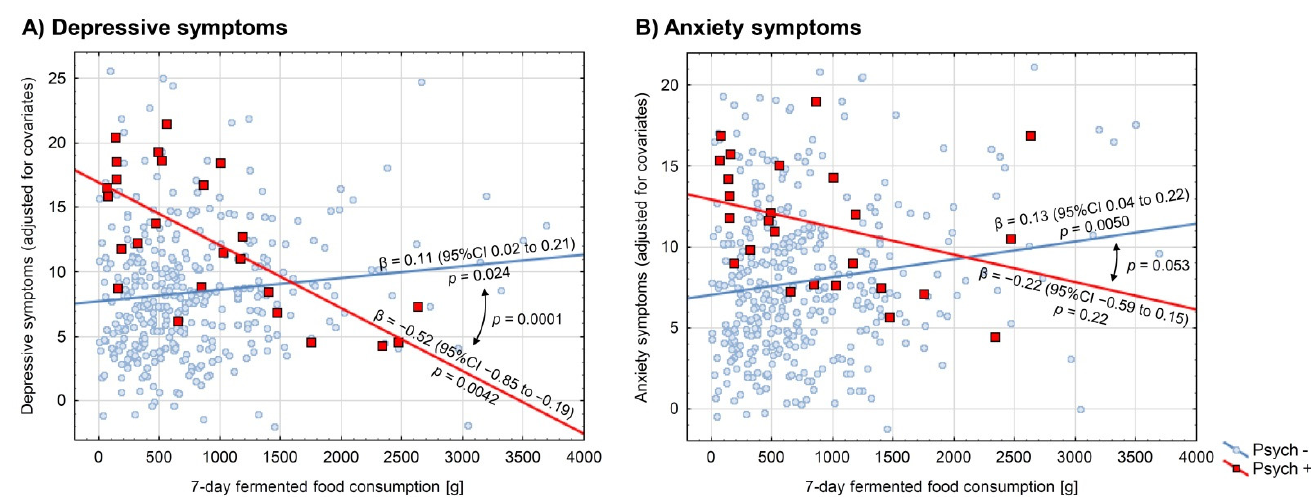
Figure 1. Association between consumption of fermented food and ( A ) depressive and ( B ) anxiety symptoms in psychiatrically ill medical students and their psychiatrically healthy schoolmates. Depressive symptoms were evaluated with the use of the Patient Health Questionnaire-9, and anxiety symptoms with the Generalized Anxiety Disorder-7. Red-squared data points and red regression lines (Psych +) represent psychiatrically ill participants ( n = 25), whereas blue-circled data points and blue regression lines (Psych − ) represent psychiatrically healthy ones ( n = 372). Regression coefficients with their 95% confidence intervals and p -values are reported near the regression lines. Comparisons of the regression lines were evaluated by the interaction models and the respective p -values were reported. All the presented analyses were adjusted for potential confounders: sex, BMI, physical activity, overall diet quality (pre-exam Starting the Conversation scale), and four out of five personality traits (Big Five Inventory-Short): neuroticism, extraversion, agreeableness, and consciousness.